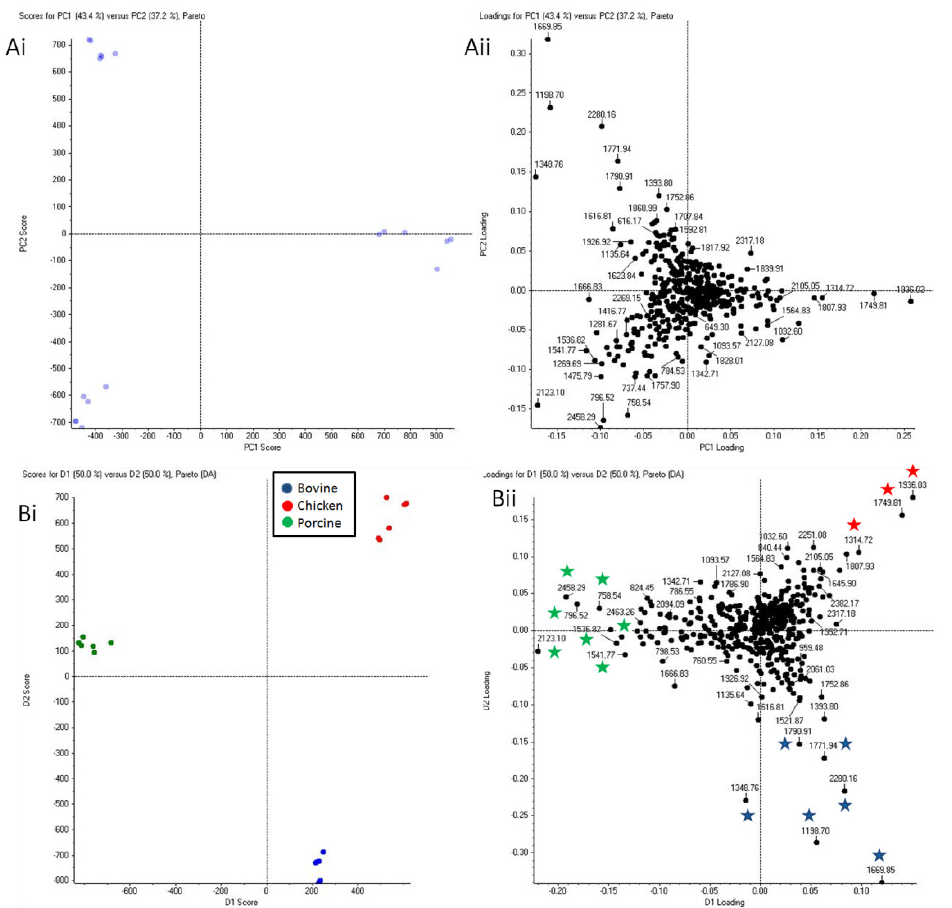
Figure 4. PCA of bovine, chicken and porcine blood collected from packaged raw meat (from just one supermarket namely Aldi). Six replicate spectra from each in solution digest were used for PCA. ( Ai , Bi ) show the unsupervised and supervised PCA score plots whereas ( Aii , Bii ) the unsupervised and supervised loading plots, respectively. The color stars in Bii refer to the animal species as color referenced in Bi . The star symbol indicates the m / z ion signals selected for MALDI MS/MS analysis. Table 4. Animal species discriminatory supervised PCA ion signals (from Figure 4) selected putative identification and MS/MS confirmation for blood in packaged meat. (NI: Not Identified; NA: not applicable).